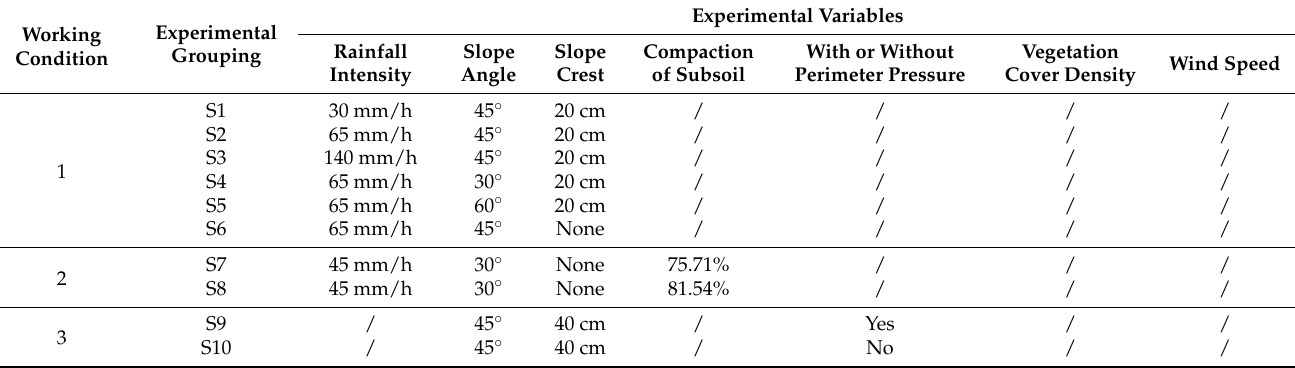
Table 1. Physical model